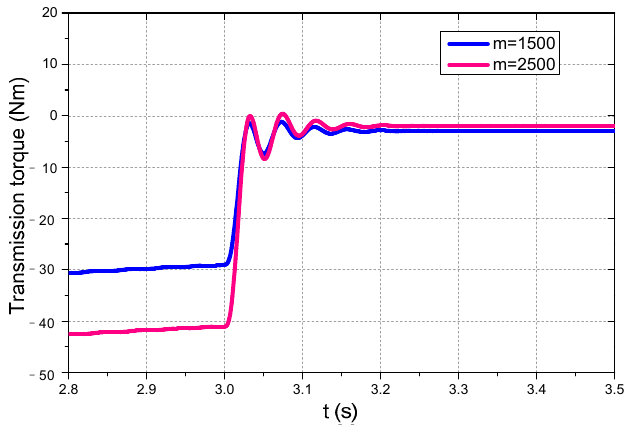
Figure A3. Torsion angle of the drive shaft.